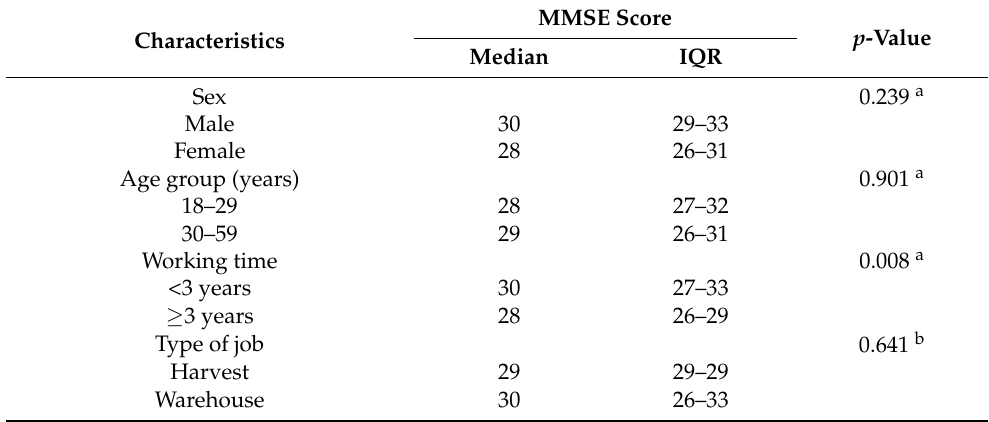
Table 2. Mini-Mental State Examination (MMSE) score by independent variables in bivariate